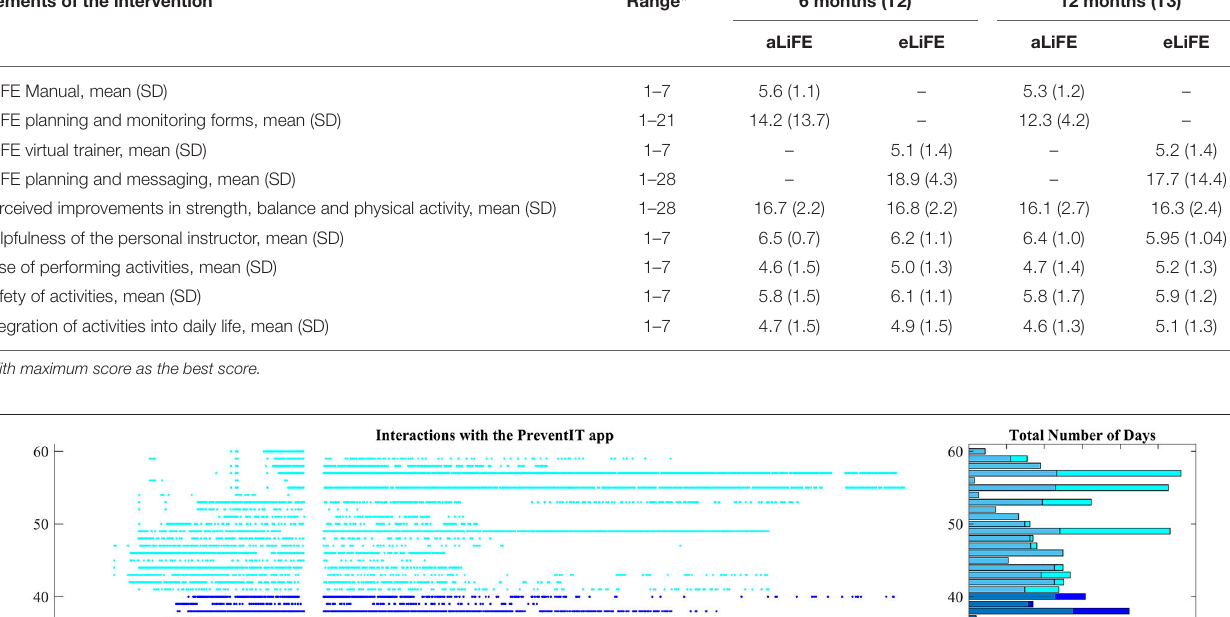
TABLE 2 | Feasibility and acceptability of the technology delivered eLiFE and the traditional aLiFE version of the intervention. Elements of the intervention